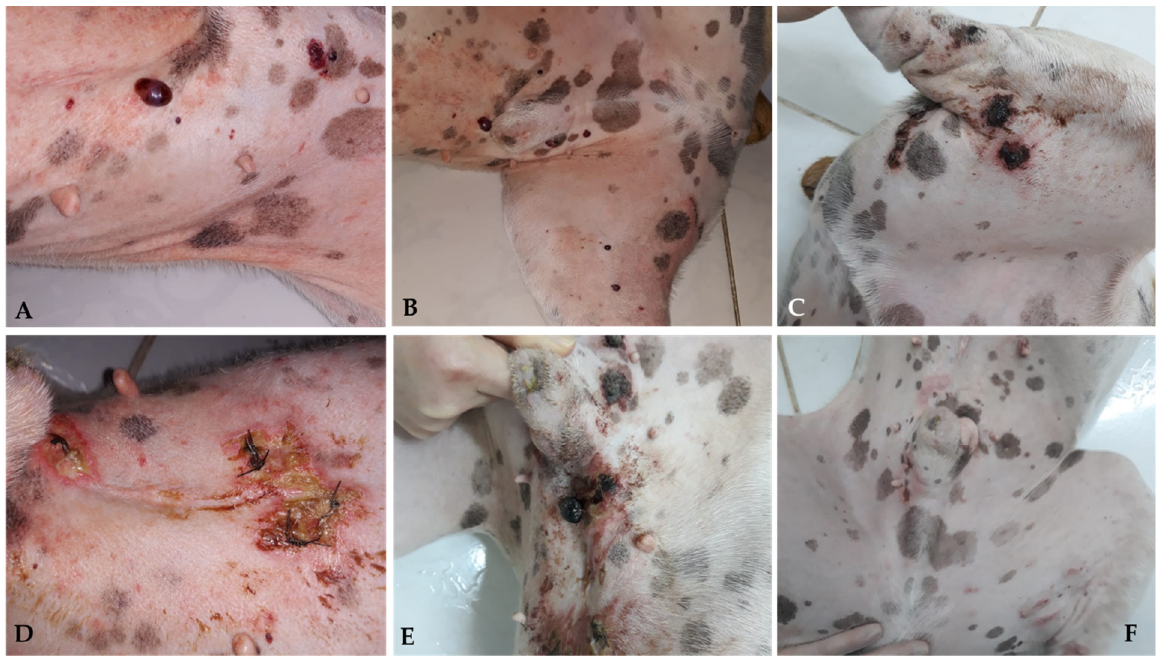
Figure 4. Canine patient diagnosed with multiple cutaneous HSA nodules; ECT with systemic BLM was administered. Multiple skin lesions are observed in the ventral abdomen and medial surface of the pelvic limb ( A , B ). Crust and ulceration 7 days after ECT ( C – E ). Complete remission 30 days after ECT with areas of scar tissue ( F ).